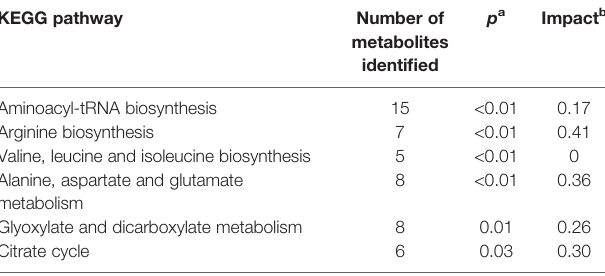
TABLE 6 | Metabolic pathways identi fi ed by the KEGG Global Metabolic Network that are signi fi cantly altered by the diet (AIN93G vs. high-fat diet)